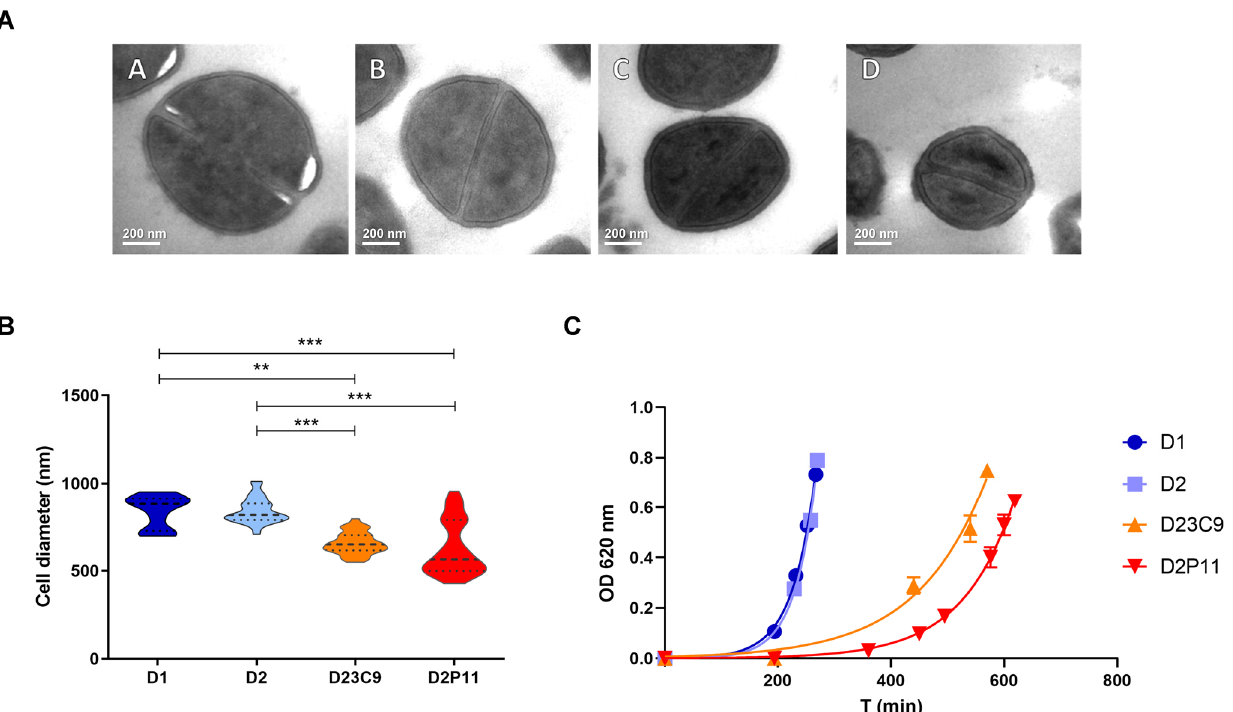
Figure 2. ( A ) Transmission electron microscopy (TEM) of representative cells; images obtained at 50,000 × . A: D1; B: D2; C: D23C9; D: D2P11. ( B ) Cell diameter measured by TEM (30 cells per strain). The results are expressed in nanometers (nm) as violin plots showing median (dashed line) and interquartile range (dots) and were compared with Kruskal–Wallis’s test ( p < 0.0001). The horizontal bars show significant differences between individual groups detected by Dunn’s multiple comparison test. ** p < 0.001; *** p < 0.0001. ( C ) Growth curves. Each point represents the mean and standard error from three independent assays. Table 6. Number of insertion sequences from Staphylococcus sp. per genome detected by ISseeker in the genomes included in this study. ISseeker identifies the termini of IS (>97% of identity) at contig edges and annotate flanking regions based on alignment of IS flanks with a reference genome.